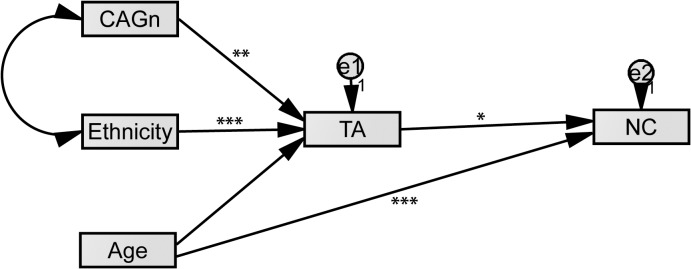
The associations between age group (Age, manifested exogenous variable), number of CAG repeats of AR gene (CAGn, manifested exogenous variable), ethnic group (Ethnicity, manifested exogenous variable) and number of children (NC, dependent variable), mediated by total aggression (TA, endogenous mediating variable) scores based on structural equation modeling; asterisks designate significance level: *- 0.01<p≤0.05, **- 0.001<p≤0.01, ***-p<0.001.